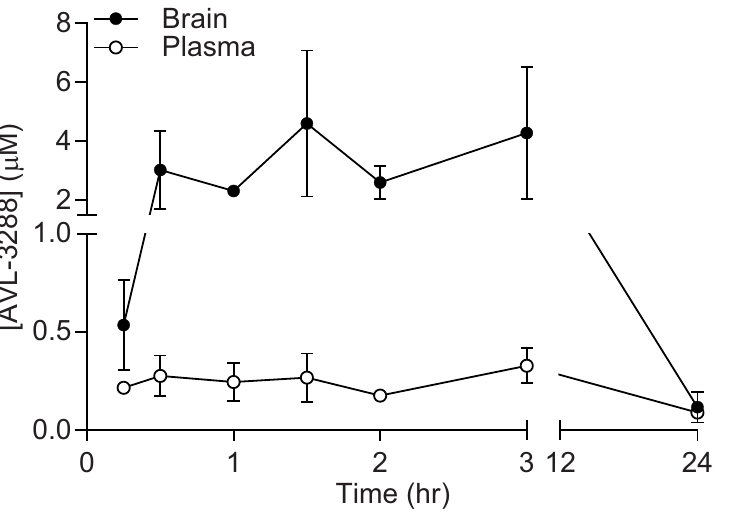
Fig 1. Pharmacokinetics. Levels ( μ M) of AVL-3288 in the brain and plasma. Na ï ve, non-injured animals were treated with AVL-3288 intraperitoneally (0.3 mg/kg in 2% DMSO, 8% Solutol, 90% saline). AVL-3288 was measured in total brain tissue and plasma by LC-MS/MS. Mean ± SEM, n =